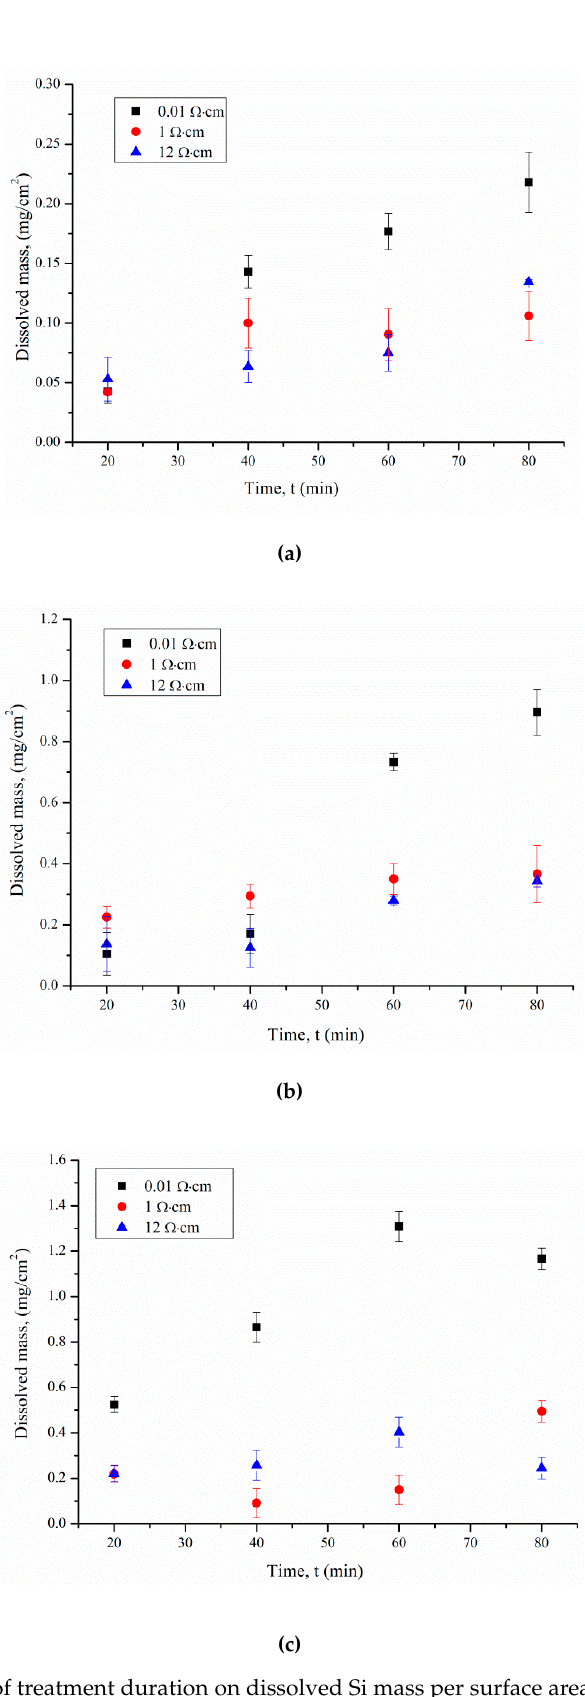
Figure 1. The e ff ect of treatment duration on dissolved Si mass per surface area ( a ) in the dark, and under ( b ) 460 and ( c ) 8000 lx